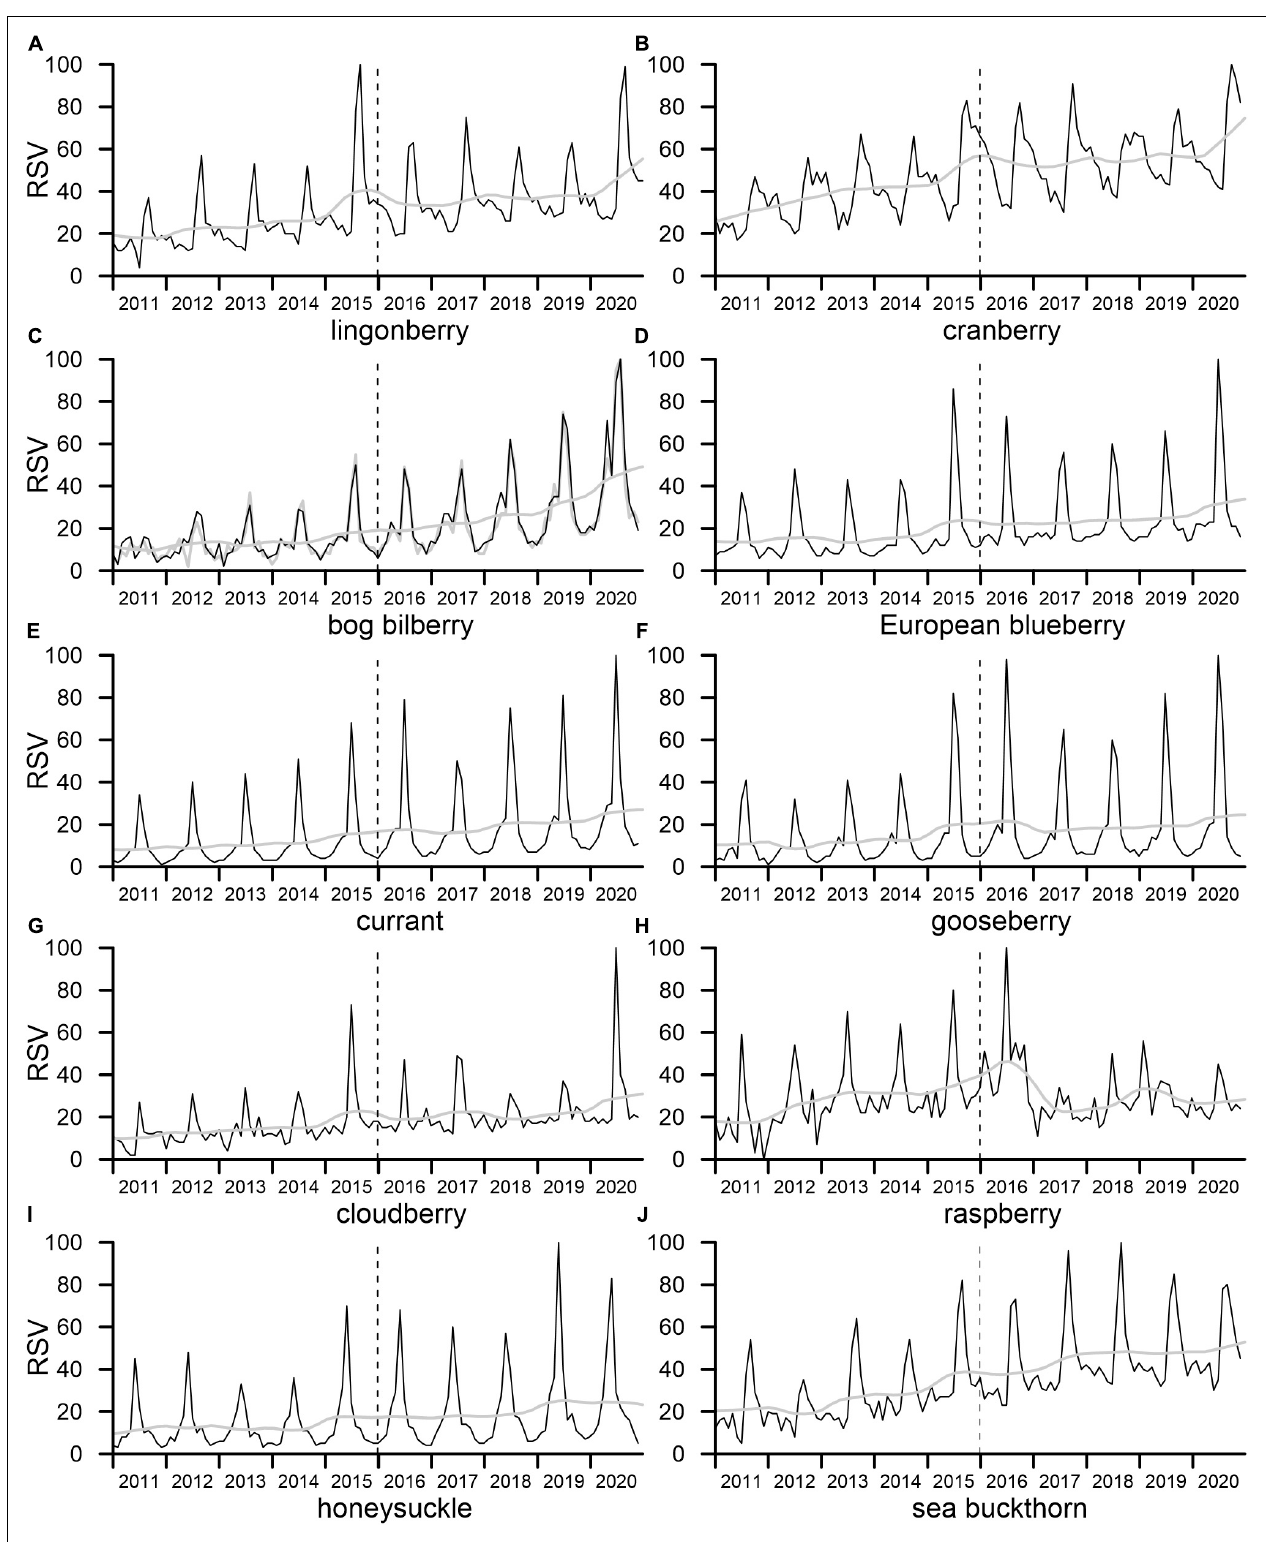
FIGURE 3 | Monthly relative search volume (RSV) for 10 years from 2011 to 2020 of (A) lingonberry, (B) cranberry, (C) bog bilberry, (D) European blueberry, (E) currant, (F) gooseberry, (G) cloudberry, (H) raspberry, (I) honeysuckle, and (J) sea buckthorn across Russia. Black and gray lines indicate RSV and its trend component, respectively. Vertical lines indicate January 1, 2016, when the GT data collection system changed.